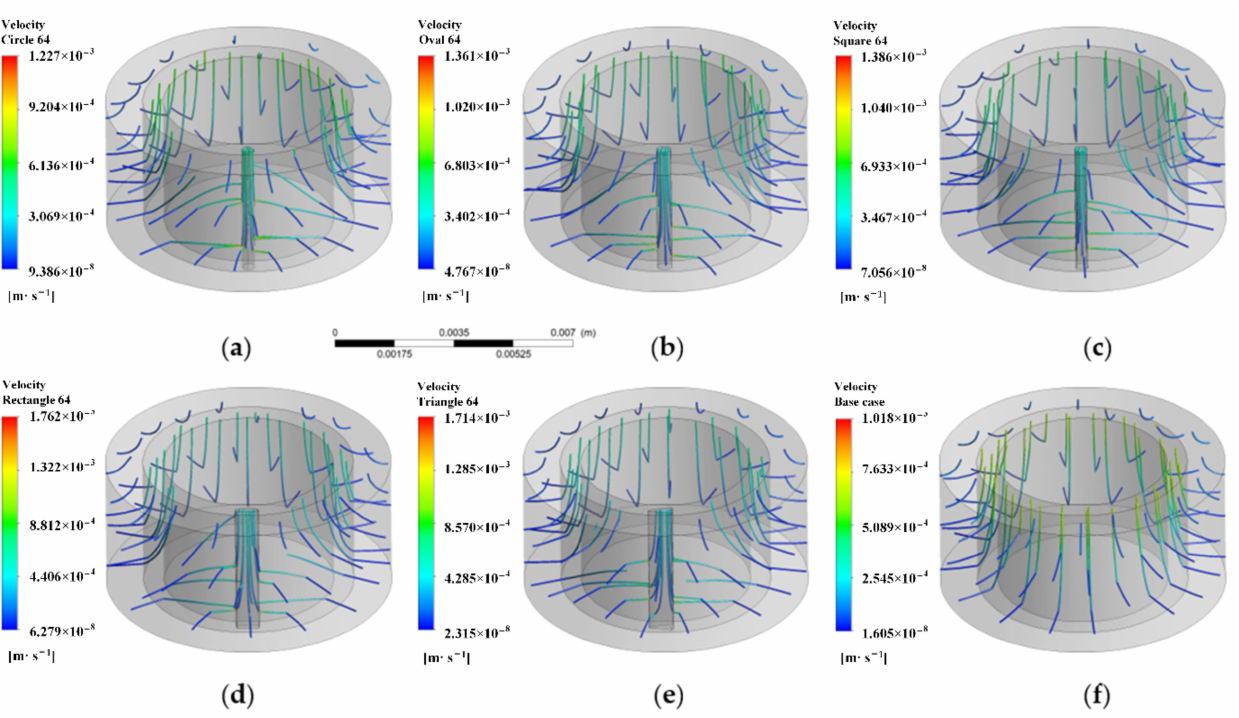
Figure 12. Effects of the presence of microchannels with different shapes on velocity streamlines through a cement–rock sample. ( a – f ): circular, oval, square, rectangular, triangular, base case. The mass flow through the cement, rock, interface and microchannel regions was extracted through post-processing. The volume flow rate of water through each section could be calculated by using Equation